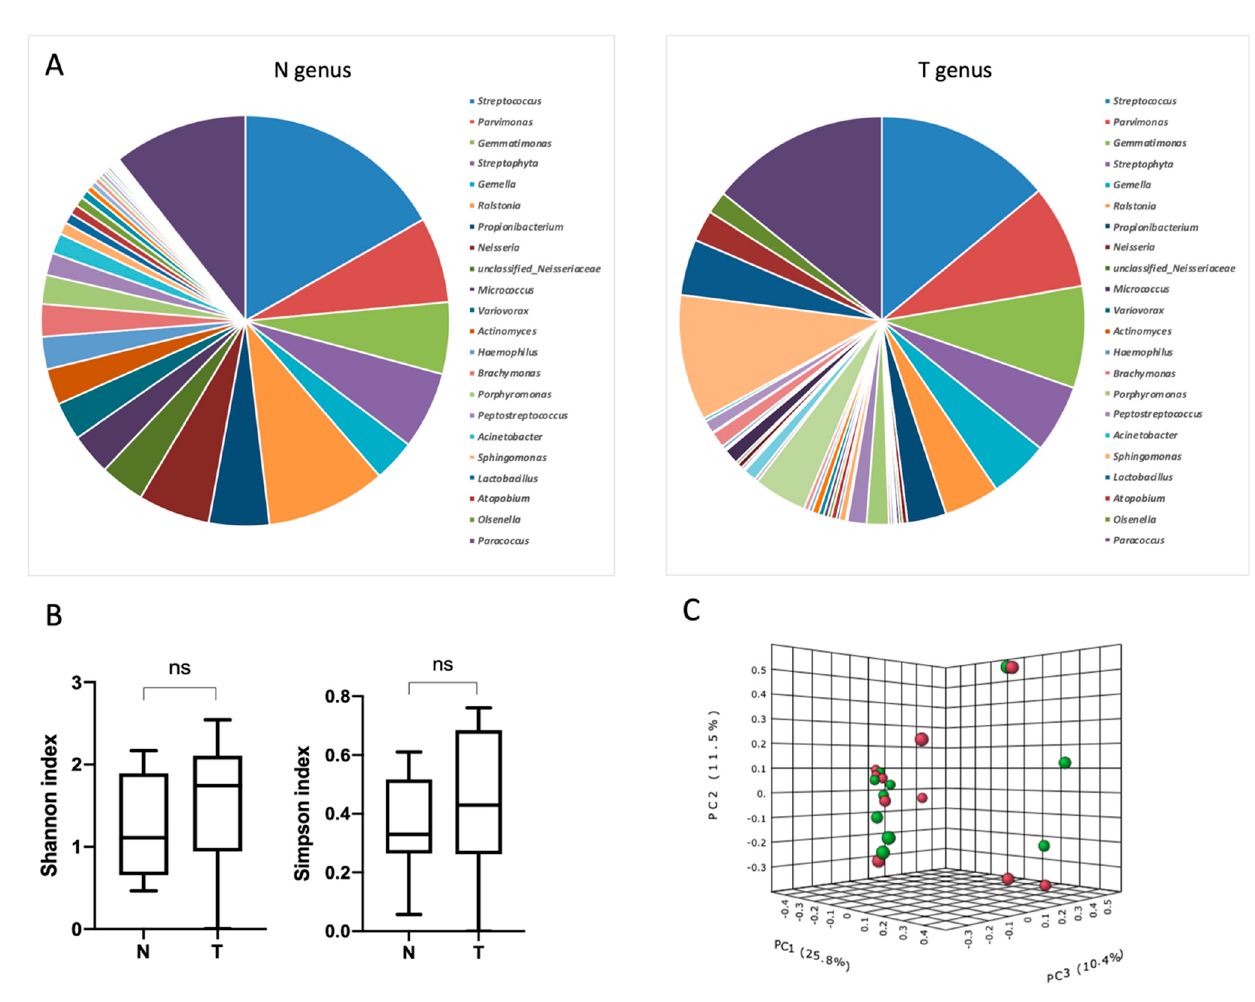
Figure 2. Taxonomic composition of the microbial community of esophageal tissues on the level of genera. ( A ) Characterization of ESSC microbiota. Relative abundance at the genus level for tumor and normal tissue samples. ( B ) Taxonomic α -diversity calculated with Shannon index and Simpson indices between N and T groups. ( C ) PCoA plot based on Bray- Curtis distance of NSCLC microbiome between tumor and normal tissues (red–N, green–T) [PERMANOVA] F–value: 0.50161; R–squared: 0.027111; p –value < 0.974.